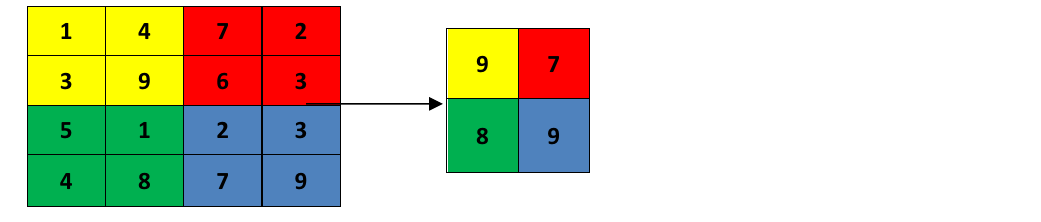
Figure 2. N-layer convolutional neural network architecture.